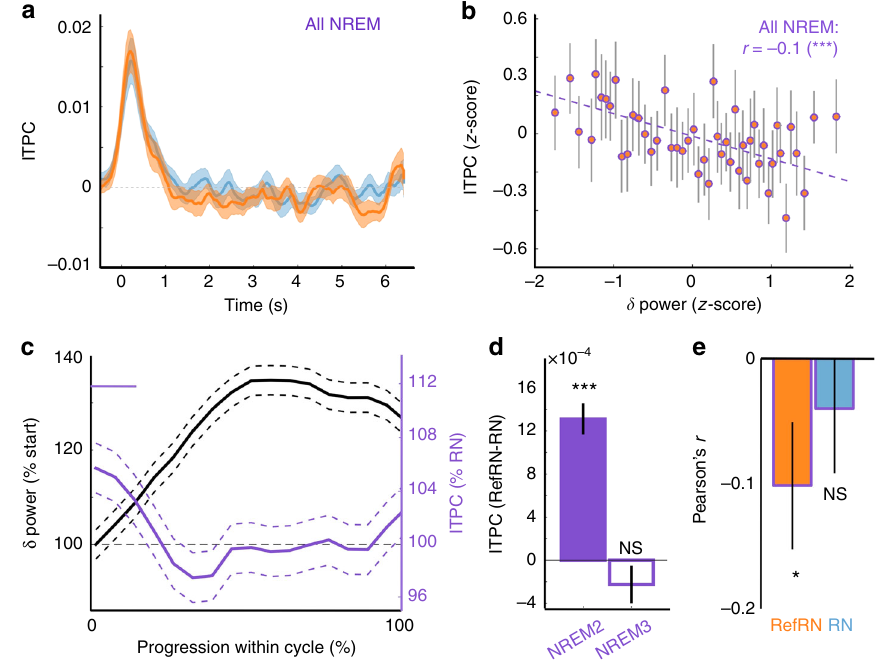
Fig. 7 The learning index is dynamically correlated with slow-wave power in NREM sleep. a Inter-trial phase coherence (ITPC) extracted around 2 Hz ([1.5, 3.5]Hz) locked to stimulus onset for RefRN ( orange curve ) and RN ( blue curve ) trials in NREM sleep (NREM2 and NREM3). ITPC was corrected by the baseline ITPC ([ − 1.3, 0.3]s). b Correlation between ITPC values computed for RefRN trials ( z -scored per sleep-cycle to highlight the within-cycle dynamics, see Methods) and δ ( < 5 Hz) power ( N = 1368 data points in 82 cycles and 18 participants). Data was binned for illustrative purpose ( N = 50 bins) and each dot represents a bin. Error bars represent the standard error of the mean (SEM) of ITPC values for each bin. Mixed-effects models revealed a signi fi